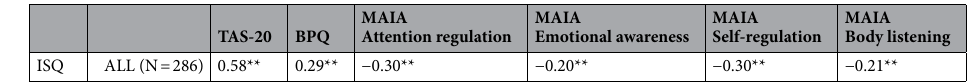
MAIA TAS-20 BPQ Attention regulation